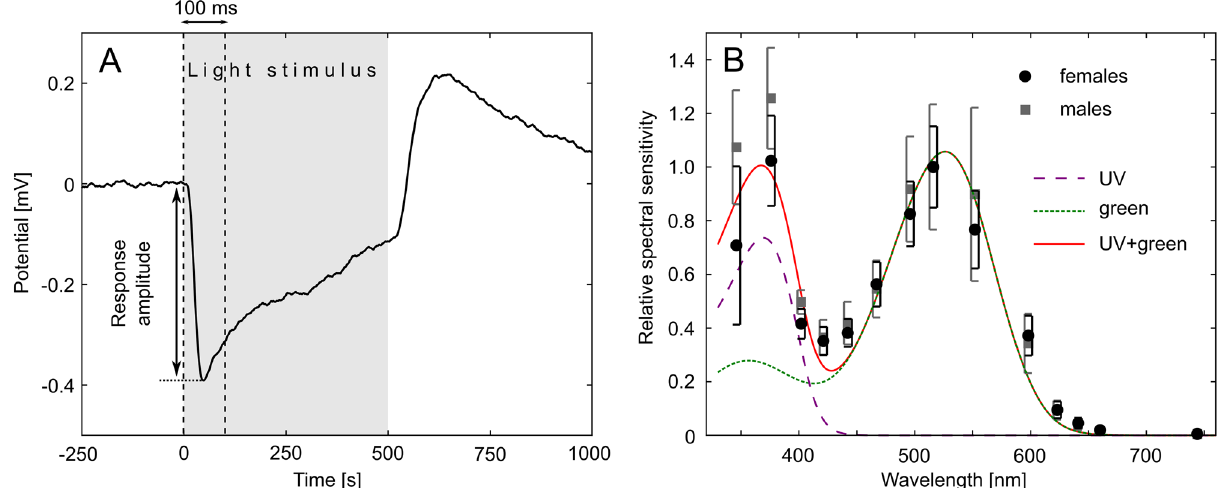
Figure 4. Electroretinogram of L. ingenua . ( A ) Time course of a typical receptor potential measured from a female L. ingenua eye preparation. Grey region represents the 500-ms-long light stimulus, and the pair of vertical dashed lines show the 100-ms-long period where the response amplitude was determined. ( B ) Mean relative spectral sensitivity of 12 female and 4 male L. ingenua eye preparations with vertical bars denoting SD. The red continuous curve shows the fitted sum of two A1-based pigment templates 41 with peak wavelengths of λ max,UV = 370.1 nm (dashed purple curve) and λ max,G = 526.3 nm (dotted green curve), respectively. Curve fitting was performed on the pooled data of females and